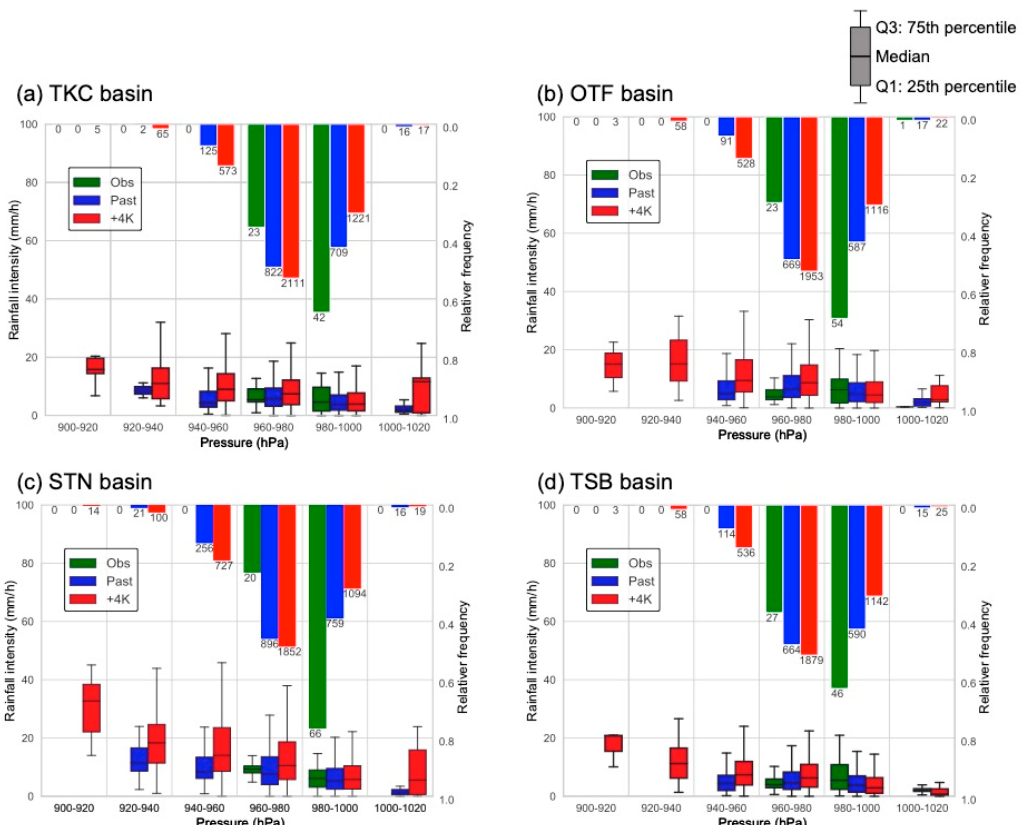
Figure 4. Basin-averaged rainfall intensity as a function of central pressure of TCs (shown in boxplot) and relative frequency of the central pressure of TCs (shown in bars) when the TC is located in the hotspot of ( a ) TKC basin, ( b ) OTF basin, ( c ) STN basin, and ( d ) TSB basin. The upper whisker of the box plot is the heaviest rainfall intensity smaller than 1.5(Q3-Q1) above the Q3. Similarly, the lower whisker of the box plot is the smallest dataset number larger than 1.5(Q3-Q1) below the Q1. The numbers of corresponding cases are shown in bars placed at the bottom of the plot.